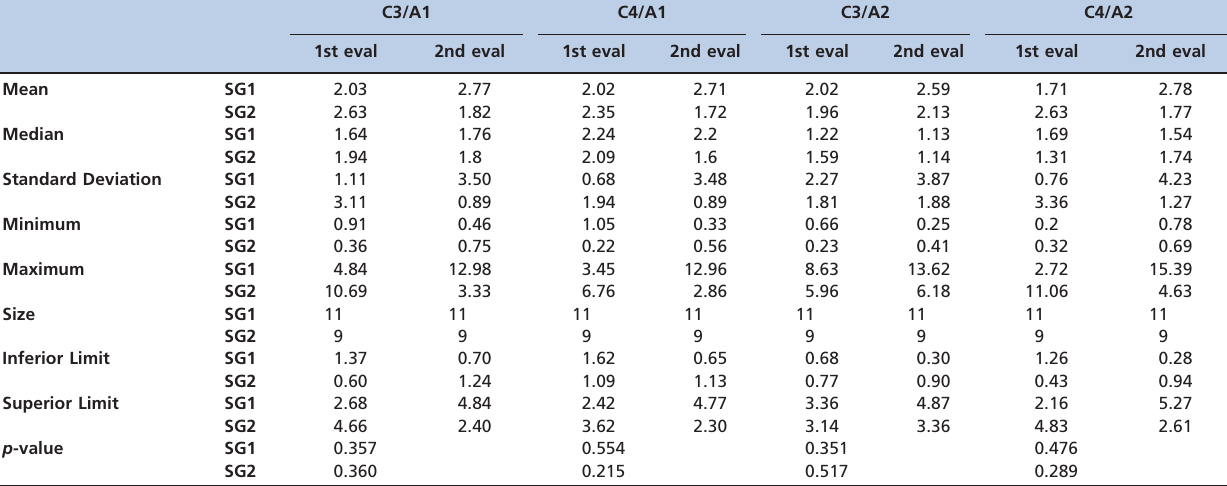
Table 4 - The comparisons between the first and second evaluations regarding the AMLR Na-Pa amplitude for subgroups SG1 and SG2 in the C3/A1, C4/A1, C3/A2, and C4/A2 modalities.